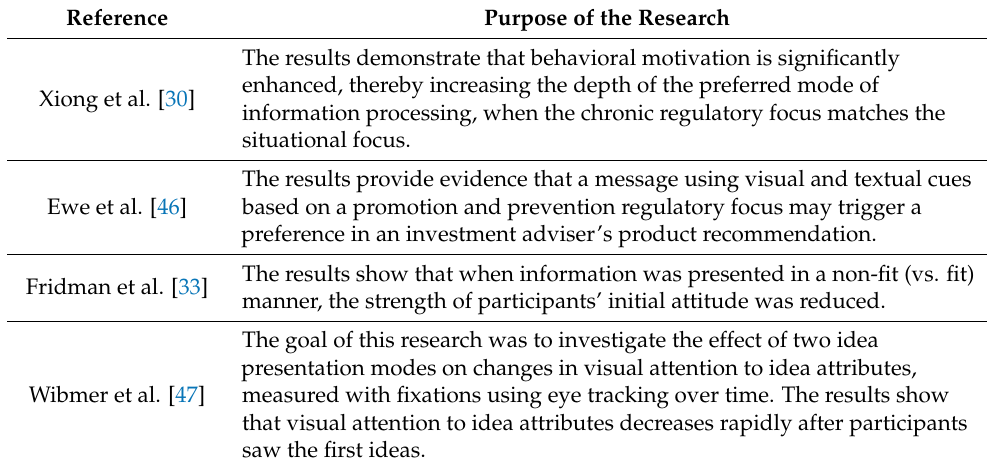
Table 1. Summary of similar